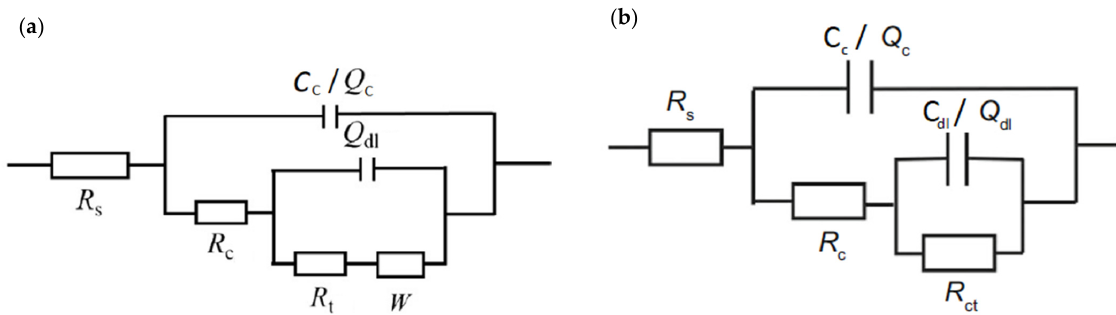
Figure 6. Equivalent electrical circuits used for the fitting of the measured data for ( a ) zinc-rich coating system A and ( b ) coating system B.